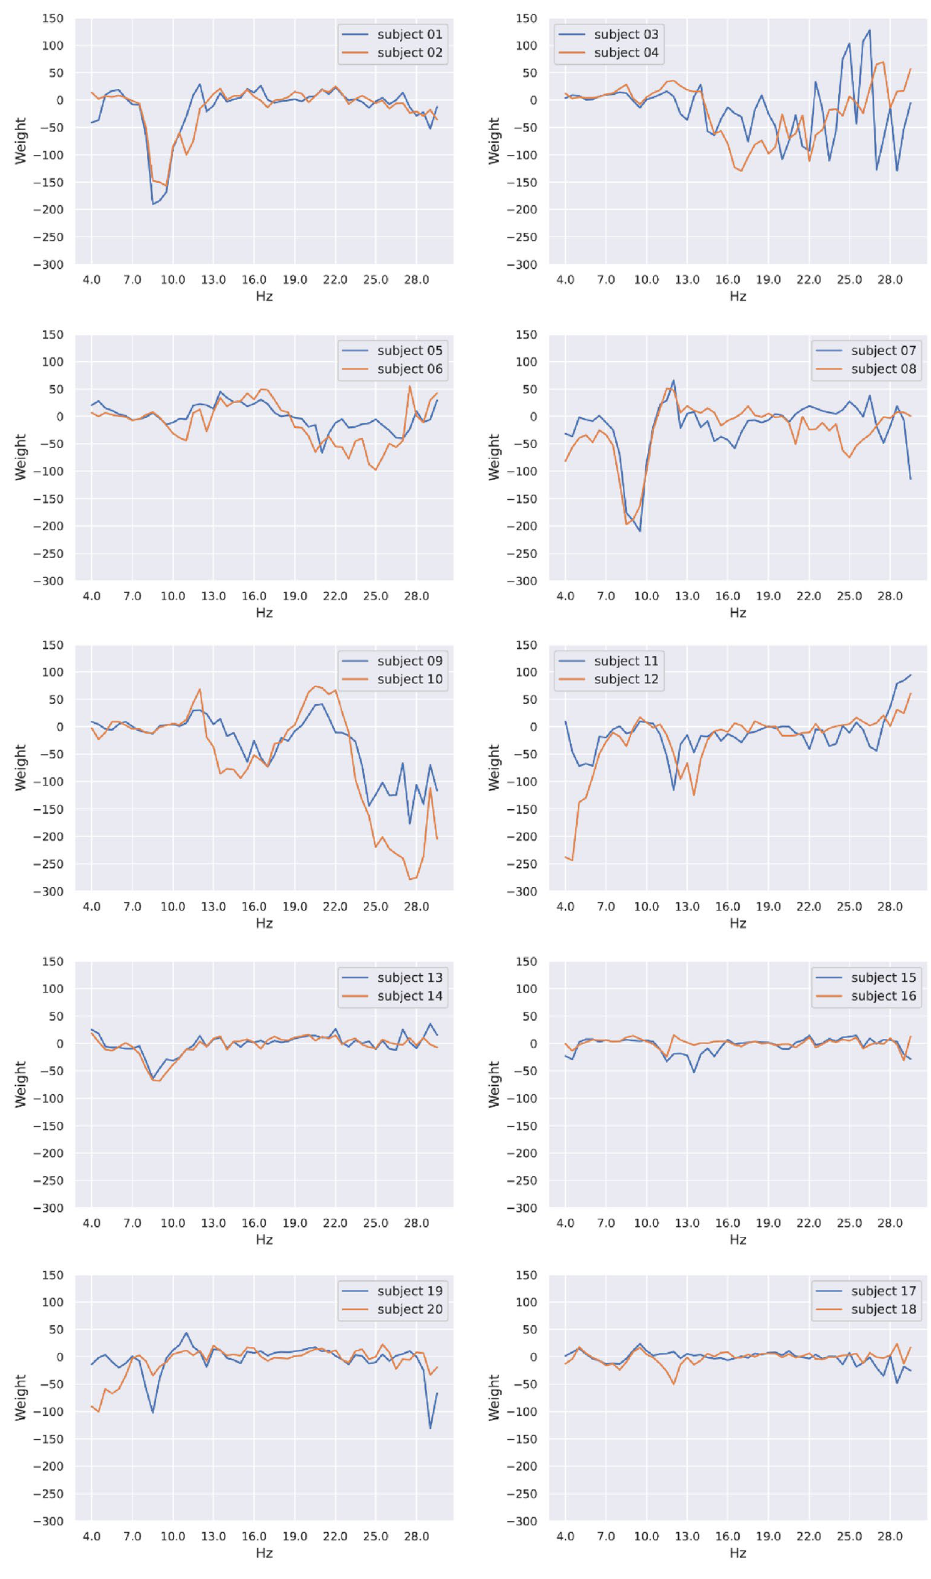
Figure 7. Spectral differences in base signals. Each panel visualizes the frequency-based weight vectors our machine classifier used to characterize the two individuals of each MZ twin